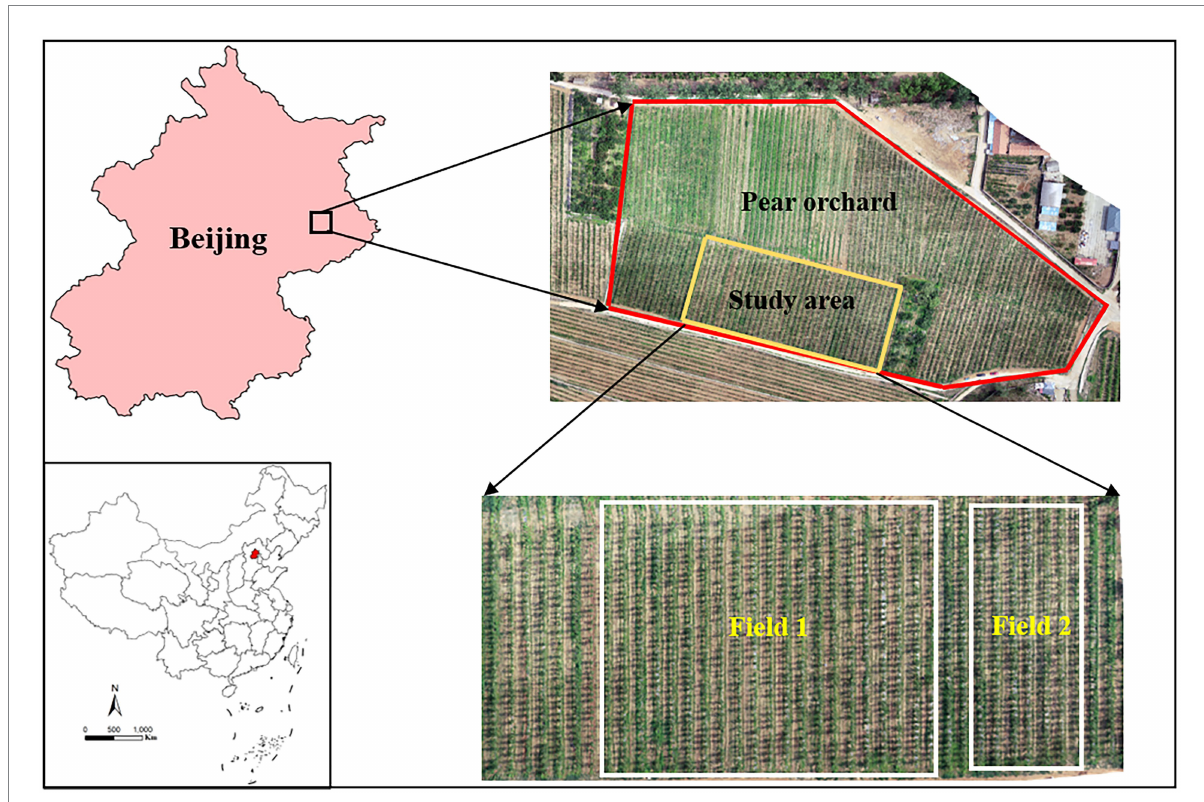
FIGURE 1 Location of the study area and test fields. Field 1 represents the test field of the unmanned aerial vehicle and ground machine spraying method; Field 2 represents the test field of the conventional artificial